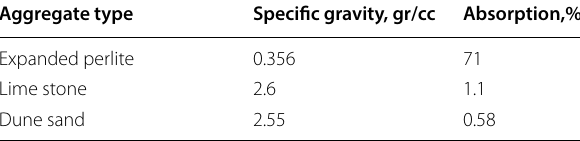
Table 1 Physical properties of various